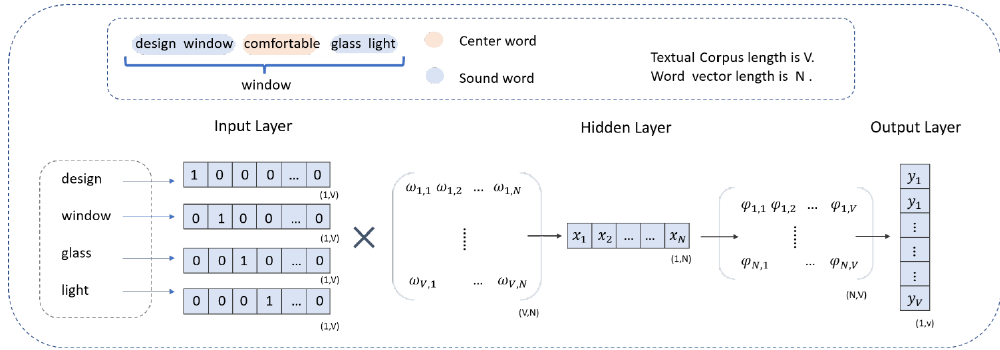
Figure 6. The word cloud of four building